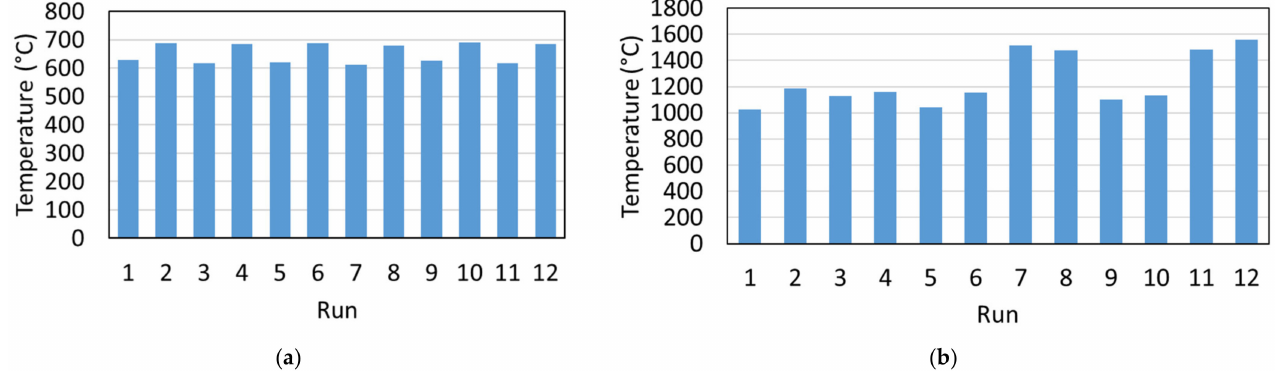
Figure 10. Average temperature at the cutting edge in the steady-state region ( a ) and maximum temperature in the drill head ( b